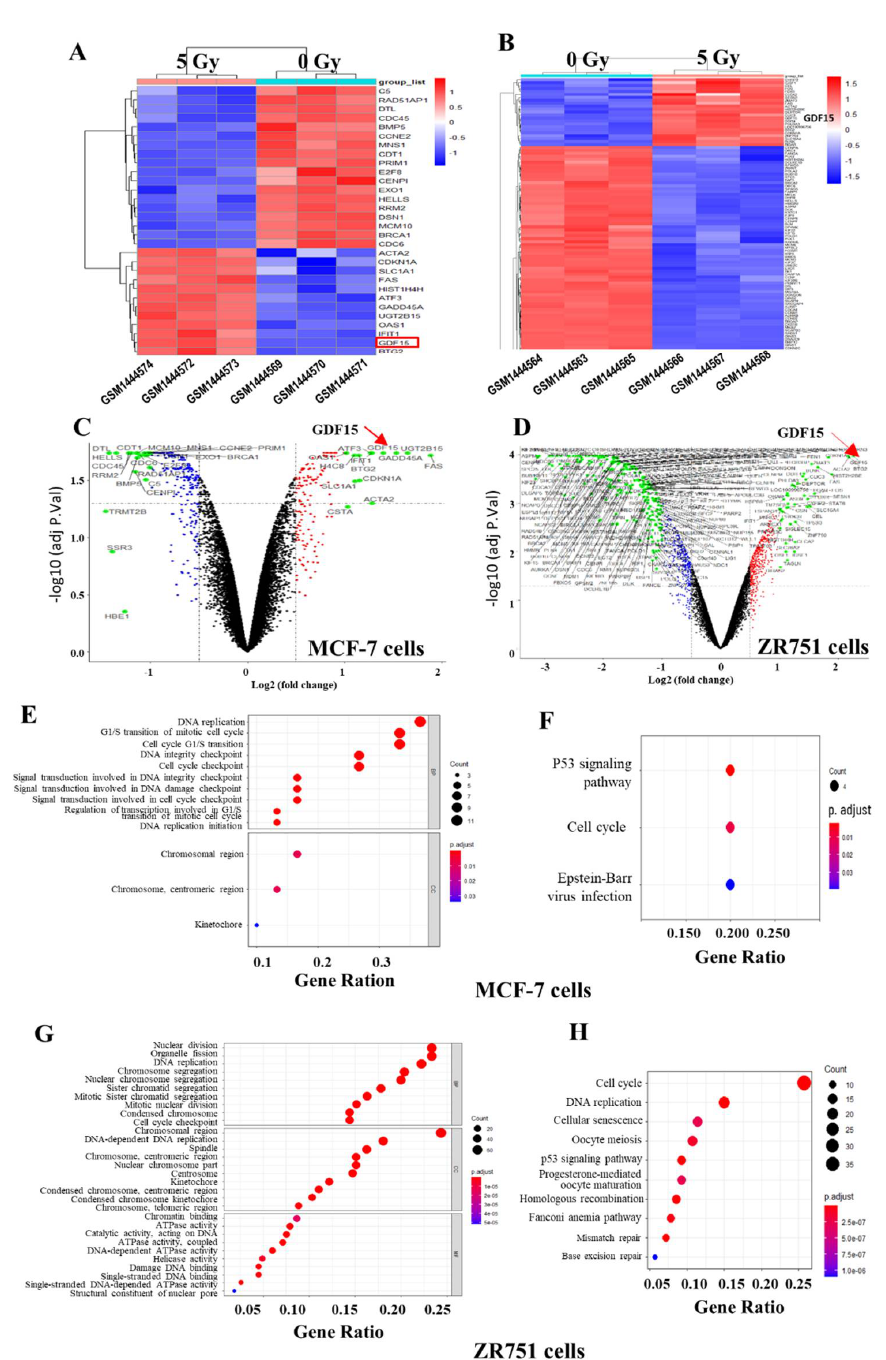
Figure 1. Identification of DEGs in the unirradiated (0 Gy) and irradiated (5 Gy) breast cancer cell lines in the GSE59732 dataset. ( A , B ) Heatmaps show 30 DEGs in MCF-7 cells ( A ) and 280 DEGs in ZR751 cells ( B ). Red and blue panes indicate the up-regulated and down-regulated genes, respectively. ( C , D ) Volcano plots of above 30 DEGs in MCF-7 cells ( C ) and 280 DEGs in ZR751 cells ( D ). Red and green dots represent the up-regulated and down-regulated genes, respectively. p < 0.05 and |log 2(FC)| > 1 are set as the threshold. ( E , G ) GO analysis of the components of biological process (BP), cellular component (CC) and molecular function (MF) of the DEGs in MCF-7 cells ( E ) and ZR751 cells ( G ). ( F , H ) KEGG analysis of the enriched pathways of DEGs in MCF-7 cells ( F ) and ZR751 cells ( H ).